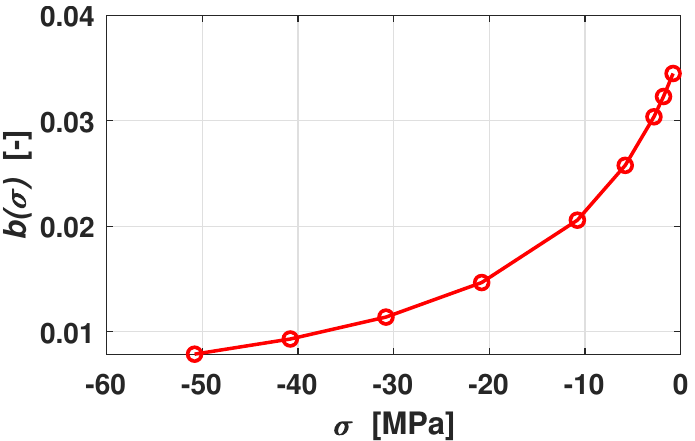
Figure 11. Trend of the b ( σ ) in Equations (20) with the k and σ 0 parameters values obtained from the minimization